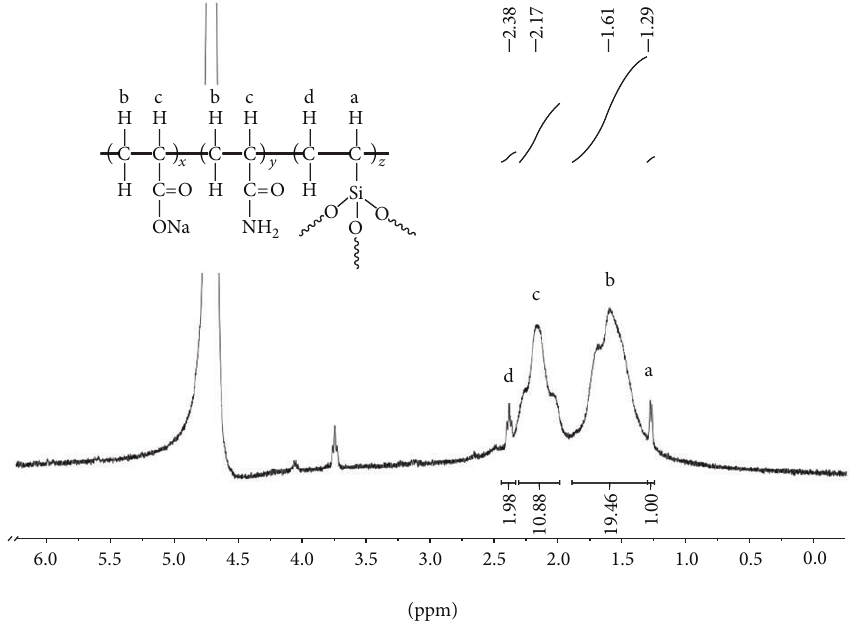
Figure 3: 1 H NMR spectrum of AM/AA/NSFM in D 2 O.